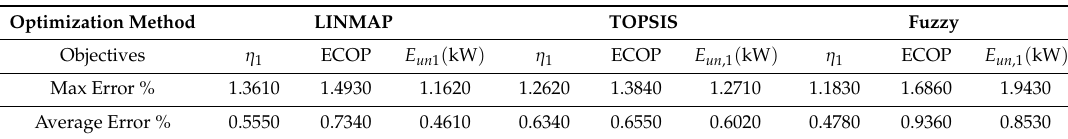
Table 2. Comparative analysis presenting mean absolute percentage error (MAPE) and maximum absolute percentage error